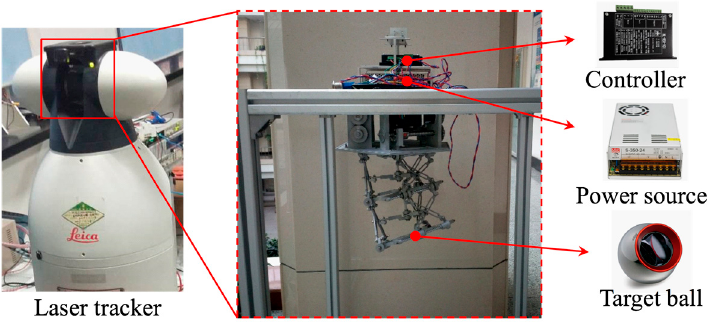
Figure 8. Experimental platform.